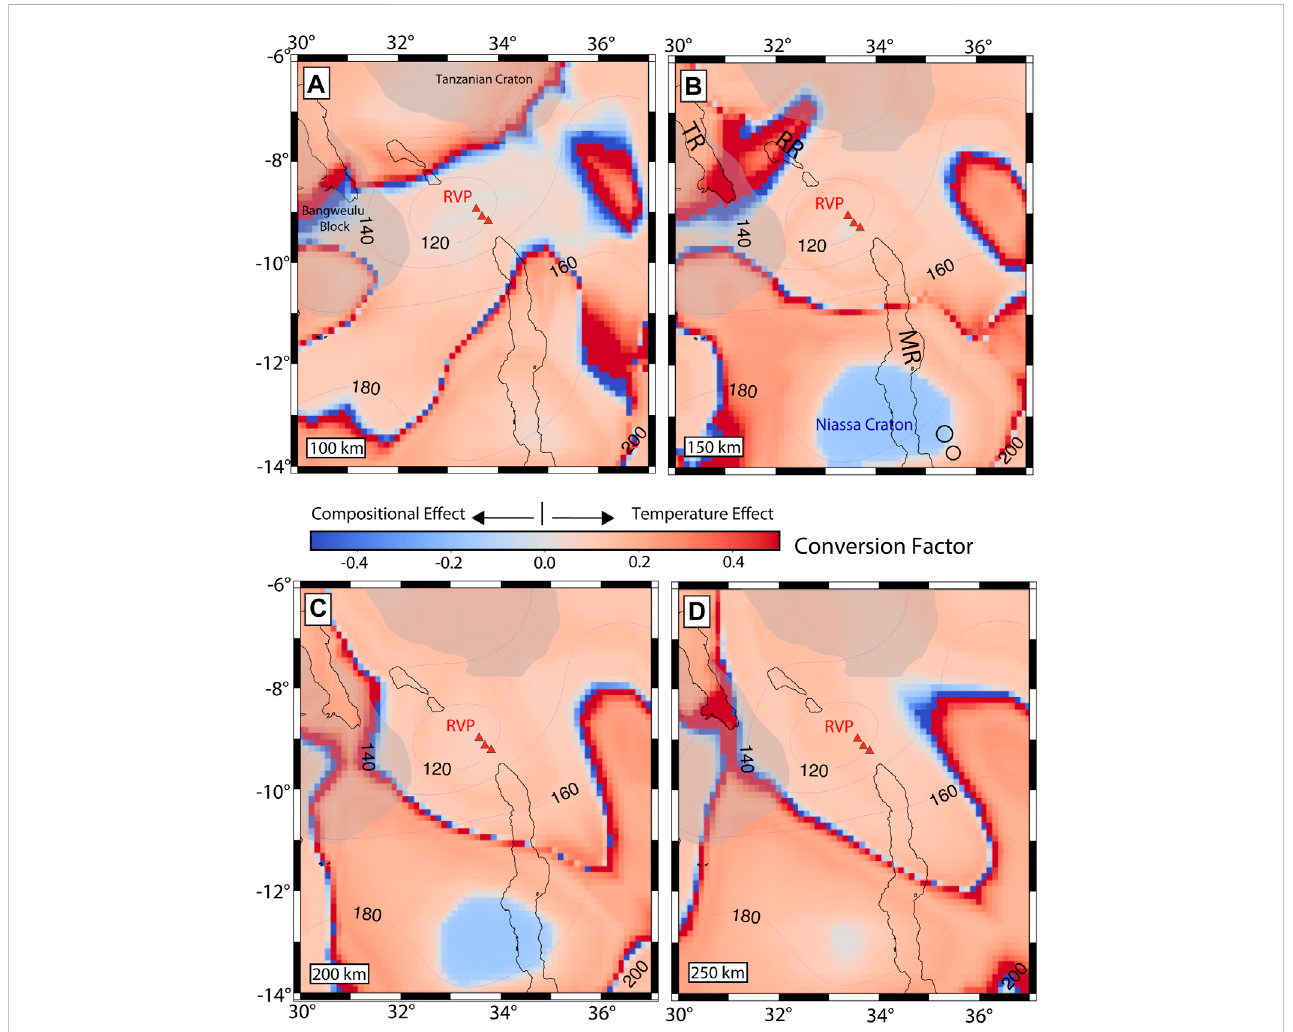
FIGURE 8 Lateraldistributionoftheconversion factorbetweentheS-wave velocityperturbations( dlnVs )andour fi naldensityanomaliesat (A) 100 km, (B) 150 km, (C) 200 kmand (D) 250 kmdepth.BlackcirclesinFigure8BrepresentthelocationofRing-ComplexesobservedonShuttleRadarTopographyMission(SRTM) Digital Elevation Model (DEM) by Njinju et al.